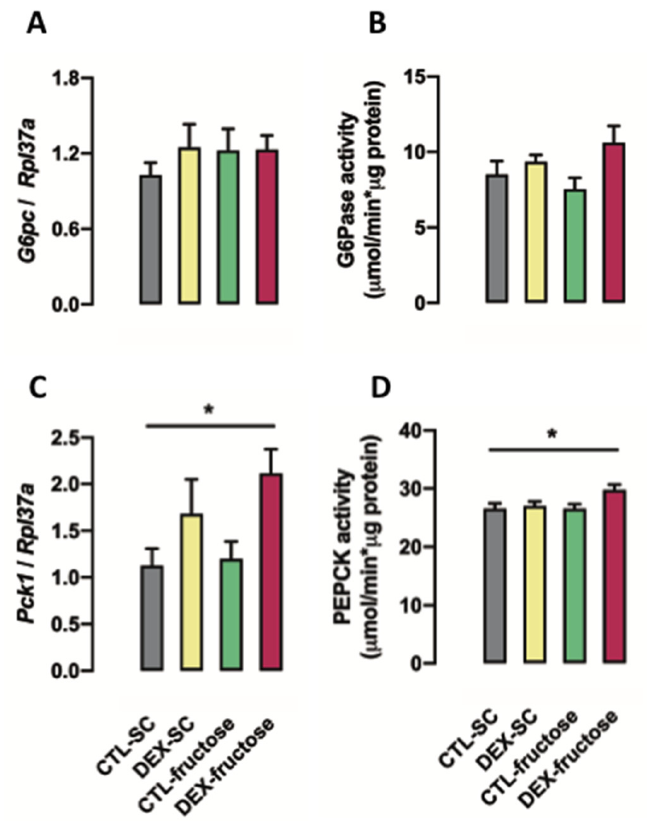
Figure 4. Expression and activity of enzymes involved in intestinal gluconeogenesis. Scraped epithelium of jejunum fragments was isolated and processed for qPCR detection of G6pc ( A ) and Pck1 ( C ) gene expression, as well as for maximum activities of the corresponding enzymes G6Pase ( B ) and PEPCK ( D ). Results are presented as mean ± standard error of the mean (S.E.M.). * p < 0.05 ( n = 6–12). Offspring born to control (CTL) mothers that received only standard chow (SC) and tap water during adult life (CTL-SC); offspring born to dexamethasone (DEX)-treated mothers that received only SC and tap water during adult life (DEX-SC); offspring born to CTL mothers that received SC plus 10% fructose during adult life (CTL-fructose); and offspring born to DEX-treated mothers that received SC plus 10% fructose during adult life (DEX-fructose).